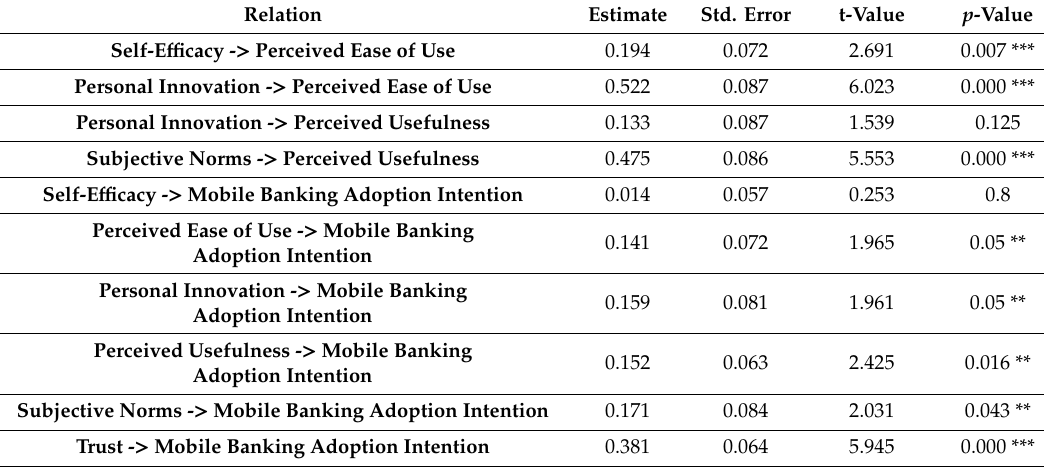
Table 7. Path Coe ffi cients.